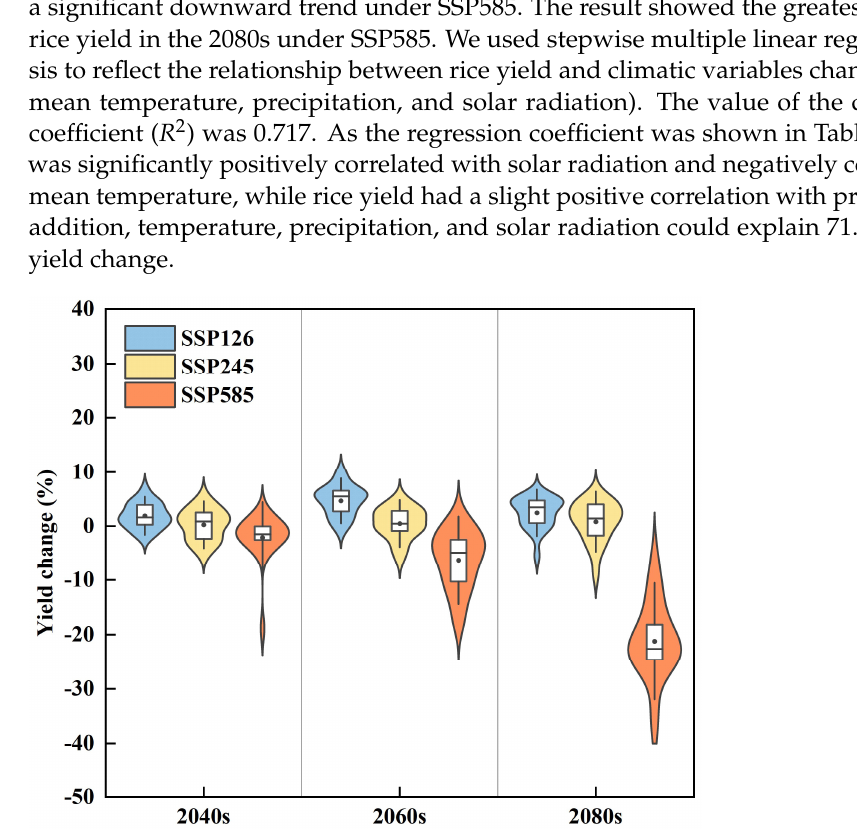
Figure 7. Simulated change in rice yield in the 2040s, 2060s, and 2080s under SSP126, SSP245, and SSP585 scenarios relative to 2000–2019 using six GCMs for Qing’an station on the Songnen Plain. The box boundaries indicate the 25th and 75th percentiles; the black line and dot within the box mark the median and mean, respectively; and whiskers below and above the box indicate mean + 1.5 SD and mean − 1.5 SD, respectively. Table 3. Coefficients of regression analysis of the impacts of climate change in rice growth period (April to September) on rice yield (Y), the light and temperature resources utilization (E RT ), light utilization efficiency (E R ), and heat utilization efficiency (HUE) change. Shown in the table are the ∆ Y (kg · ha − 1 ), ∆ E RT (%), ∆ E R (%), and ∆ HUE (kg/(hm 2 · ◦ C · d) as a function of change in mean temperature ( ∆ T mean , ◦ C), precipitation ( ∆ Prec , mm), and solar radiation ( ∆ Rad, MJ · m − 2 ). Item b ∆𝑌 = 𝑎∆𝑇 + 𝑏∆𝑃𝑟𝑒𝑐 + 𝑐∆𝑅𝑎𝑑 (cid:3040)(cid:3032)(cid:3028)(cid:3041) ∆E = 𝑎∆𝑇 + 𝑏∆𝑃𝑟𝑒𝑐 + 𝑐∆𝑅𝑎𝑑 (cid:3019)(cid:3021) (cid:3040)(cid:3032)(cid:3028)(cid:3041)